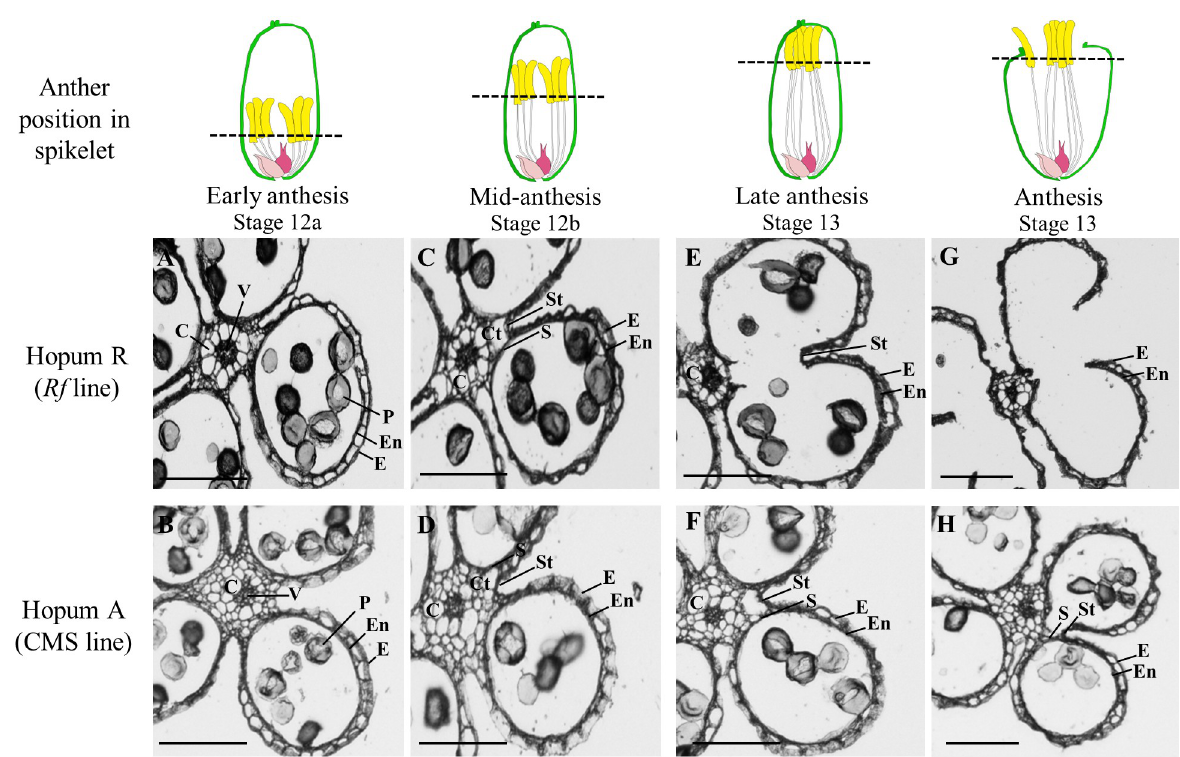
Fig 2. Transverse sections of Hopum R and Hopum A anthers at different stages of anthesis. (A, B) Early anthesis: Stage 12a. (C, D) Mid- anthesis: Stage 12b. (E, F) Late anthesis: Stage 13. (G, H) Anthesis: Stage 14. C: connective tissue; V: vascular bundle; M: mature pollen; En: endothecium; E: epidermis; Ct: cavity for dehiscence; S: septum; St: stomium. Dotted lines indicate the position of sectioning. Scale bars = 250 μ m.